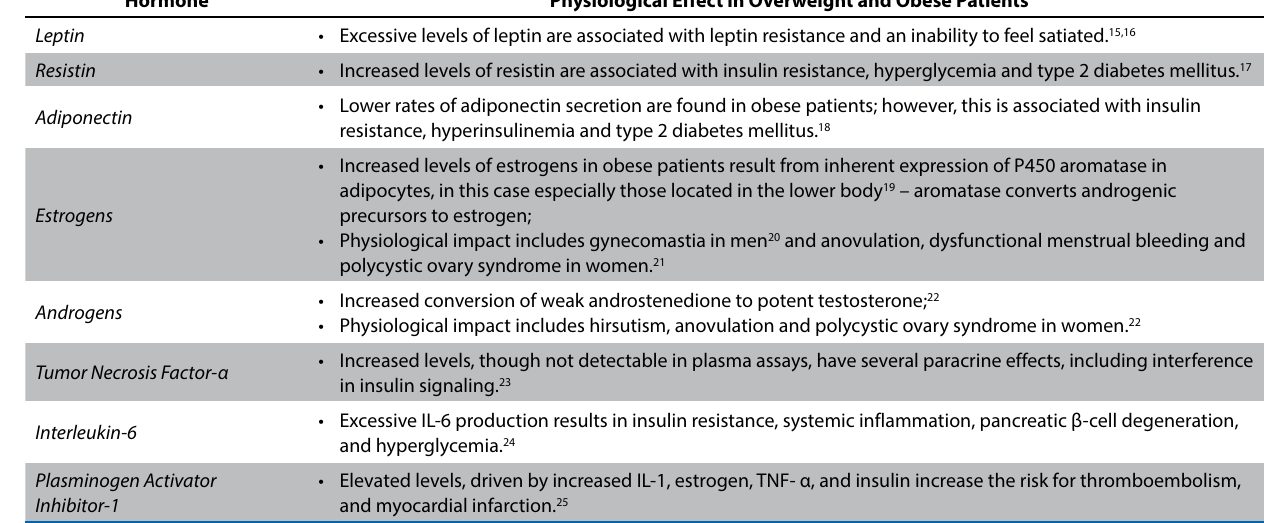
Table 2 - Adipose tissue as an endocrine organ